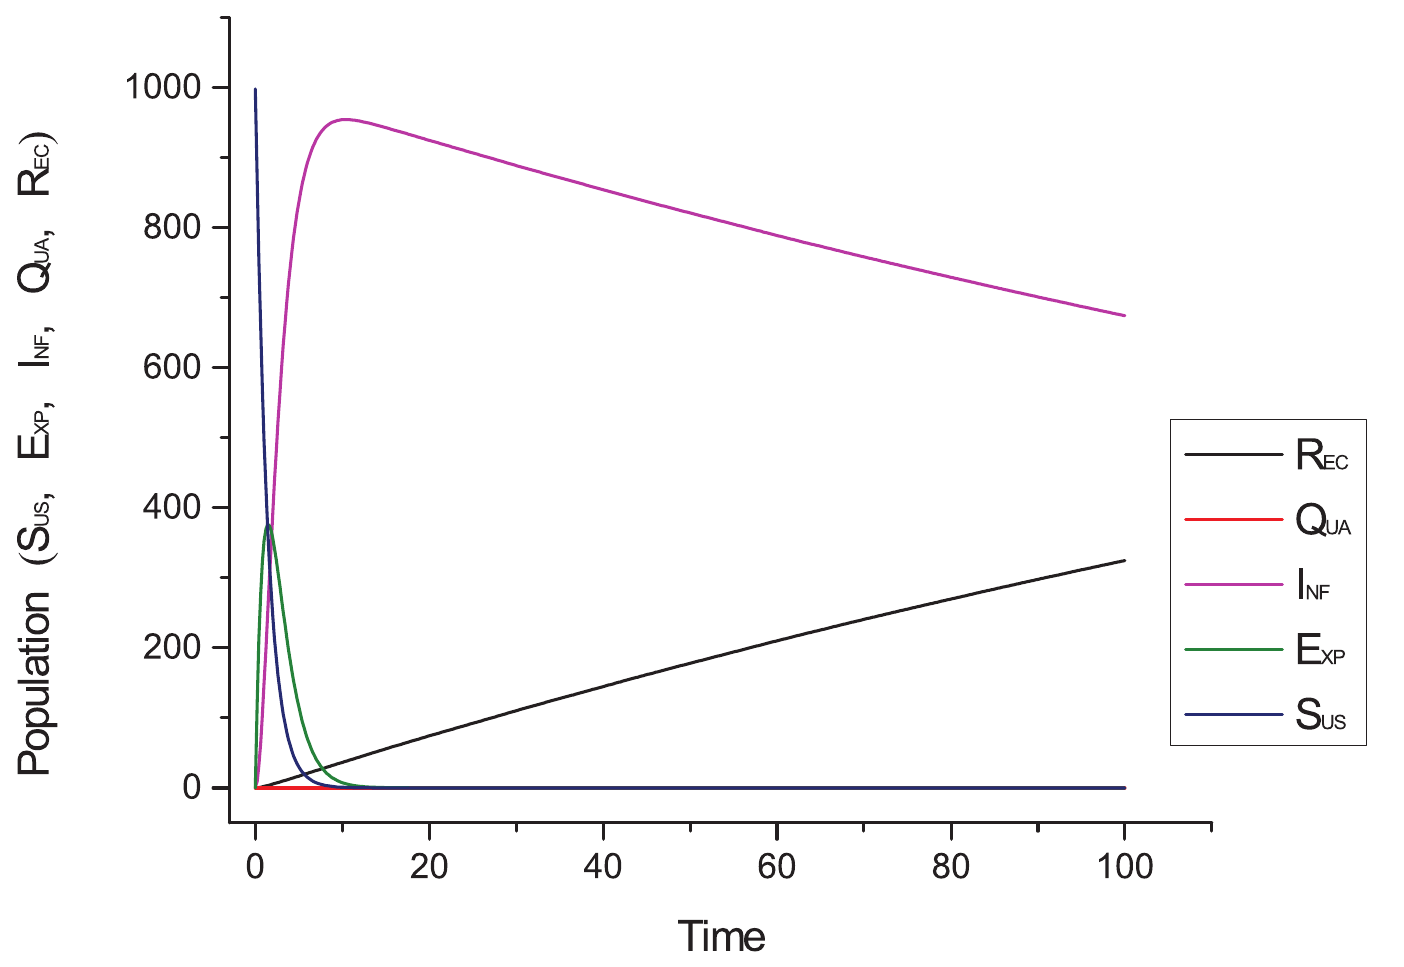
Fig 8. Dynamical behaviour of the proposed system without